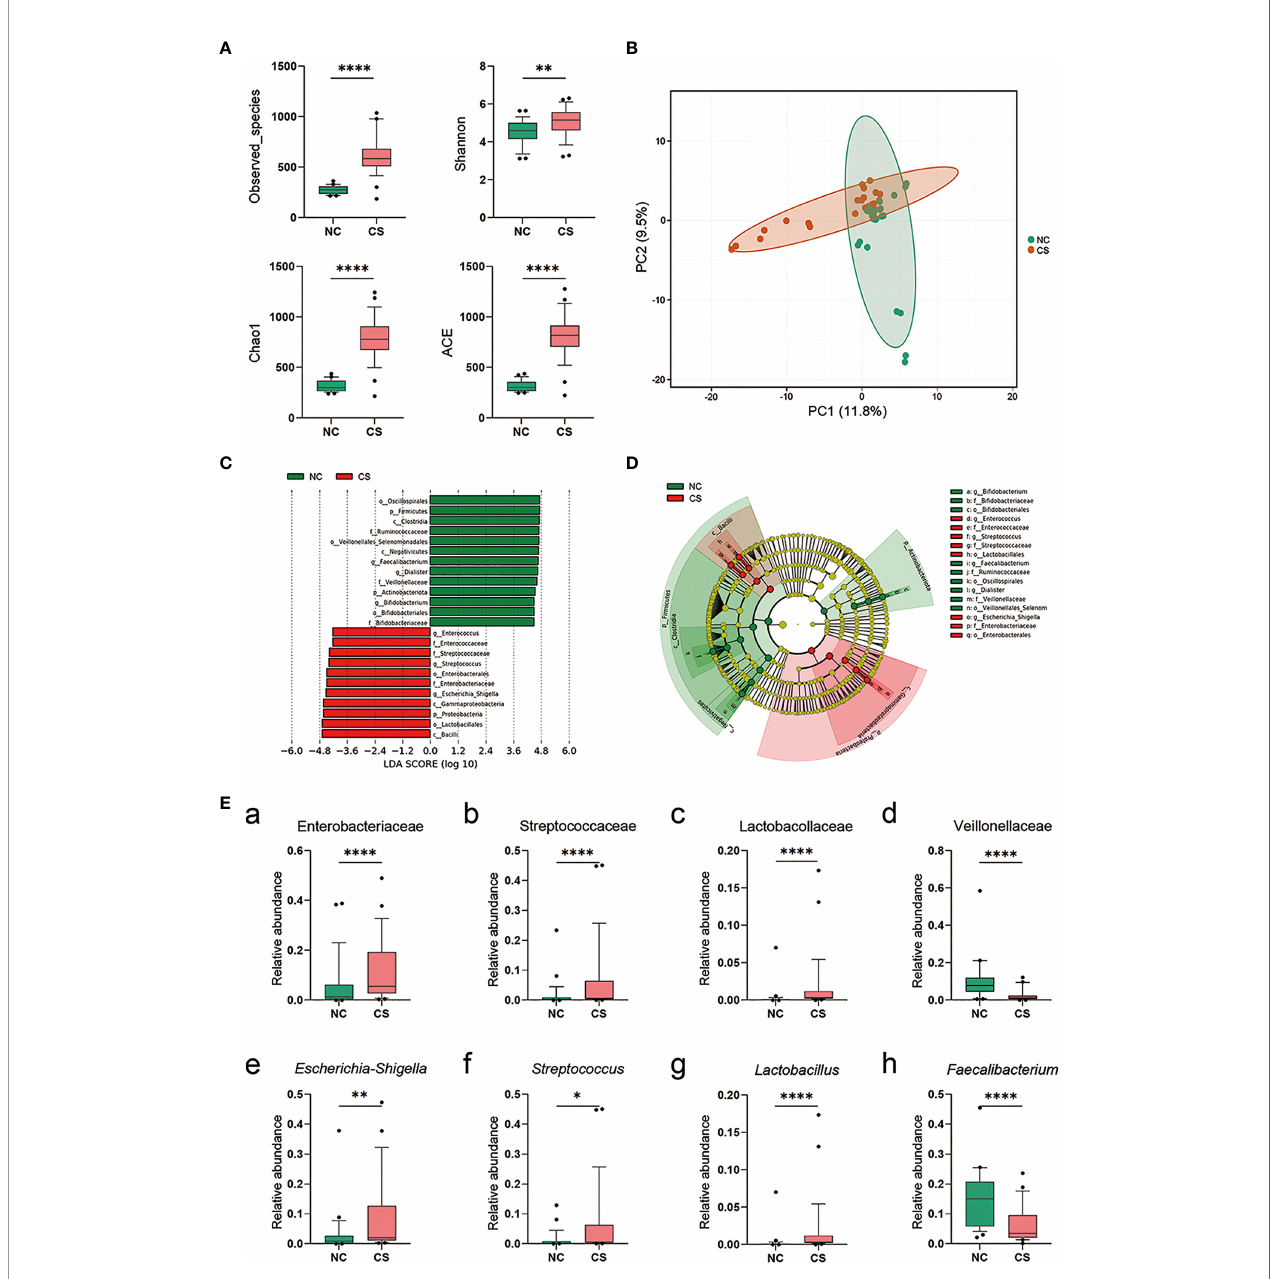
FIGURE 3 | Comparison of the representative taxonomic abundance between CS patients and NCs. (A) Alpha diversity of gut microbiota between CS patients and NCs. The Observed_species, Chao1, Shannon, and ACE index values. (B) PCA scores based on the relative abundances of OTUs (at the 97% similarity level). (C) Histogram of the linear discriminant analysis (LDA) scores for differentially abundant bacterial taxa between two groups (LDA score threshold: ≥ 4.0). (D) Cladogram of the LEfSe analysis of the gut microbiota in NC group (green) and CS group (red). Rings from the inside out represent taxonomic levels from phylum to genus, and sizes of the circles indicate the relative abundance levels of the taxa. (E) Relative abundance of intestinal microbiota at the family level (a – d) and genus level (g – h) . p < 0.05 indicates statistical signi fi cance (* p < 0.05, ** p < 0.01, **** p < 0.0001). CS, cryptogenic stroke; NCs, normal controls; PCA, principal component analysis; OTUs, operational taxonomic units; LEfSe, linear discriminant analysis effect